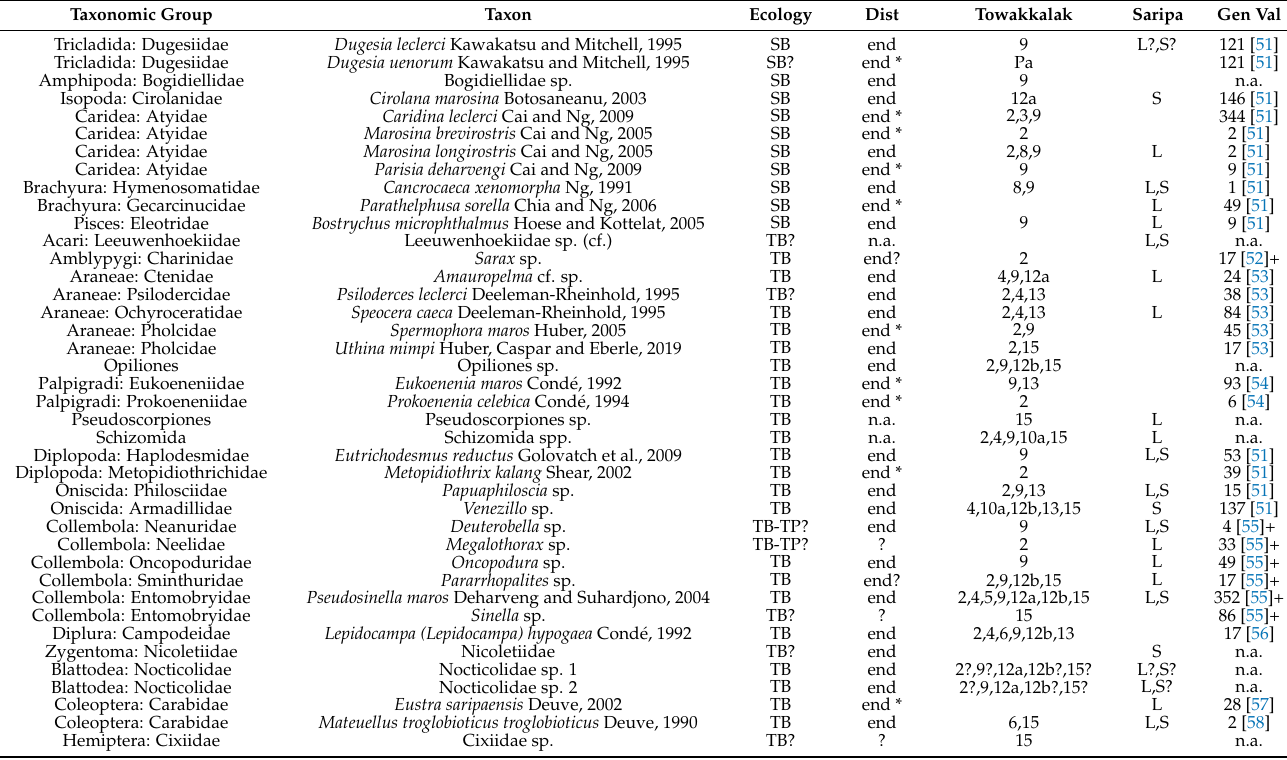
Table 1. Stygobiotic and troglobiotic species of the Towakkalak and Saripa systems. Abbreviations—Ecology: SB, stygobiont (aquatic); TB, troglobiont (terrestrial). Distribution (dist): end, restricted to the Maros karst; end *, restricted to a single